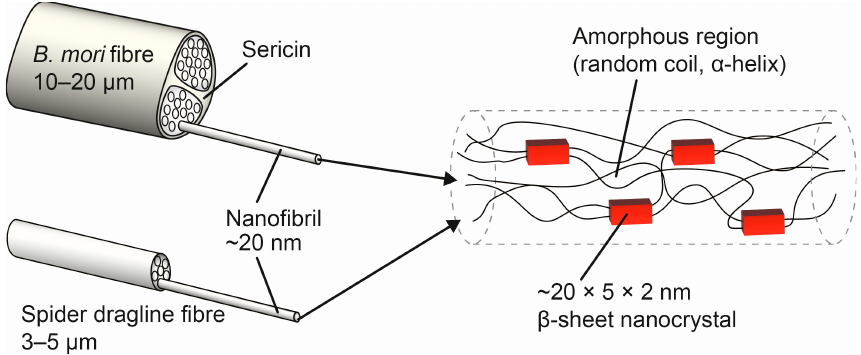
Figure 1. Hierarchical structure of spider and silkworm silks, showing that both consist of a protein core of tightly packed nanofibrils within a protein matrix, with silkworm silks further surrounded by a layer of sticky protein called sericine. The nanofibrils proteins are orientated along the fibre axis and are comprised of β -sheet nanocrystals embedded in a rubbery, amorphous matrix containing predominantly random coil and α -helix structures.